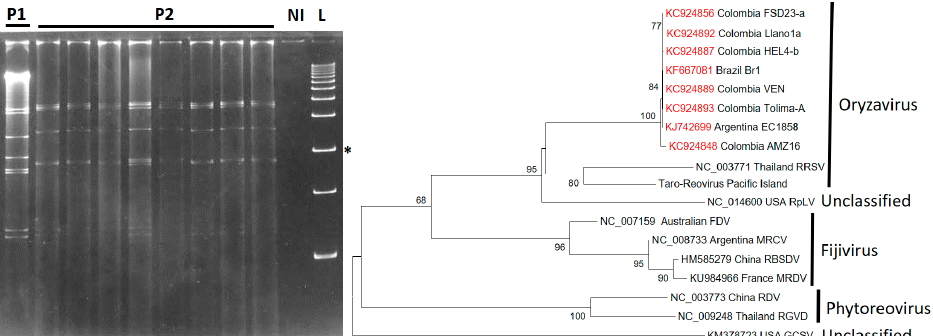
Figure 6. Distinct patterns of dsRNA detected in cassava plants affected by CSFD. Cuervo reported at least two dsRNA patterns in plants with CFSD [10]. Both patterns show 10 dsRNA bands. Left: Patterns P1 and P2 can be detected in samples from the Amazon region of Colombia. P2 is more common in samples from other regions (photo kindly provided by M. Cuervo). NI = Not infected control. L = 1 kb ladder. The asterisks indicates the 2 kb band. Right: Phylogenetic analysis of reovirids infecting plants based on the amino acid sequence of the RdRp domain. RRSV = Rice ragged stunt virus (NC_003771); RpLV = Raspberry latent virus (NC_014600); FDS = Fiji disease virus (NC 007159); MRCV = Mal de Rio Cuarto virus (NC 008733); RBSDV = Rice black-streaked dwarf virus (HM585279); MRDV = Maize rough dwarf virus (KU984966); RDV = Rice dwarf virus (NC 003773); RGVD = Rice gall dwarf virus (NC_009248); GCSV = Grapevine Cabernet Sauvignon reovirus (KM378723).